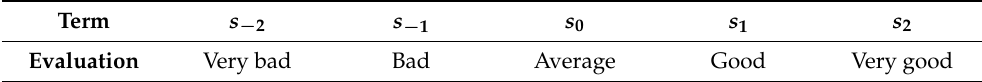
Table 3. Linguistic Term Set S for evaluating ontology criteria. Term